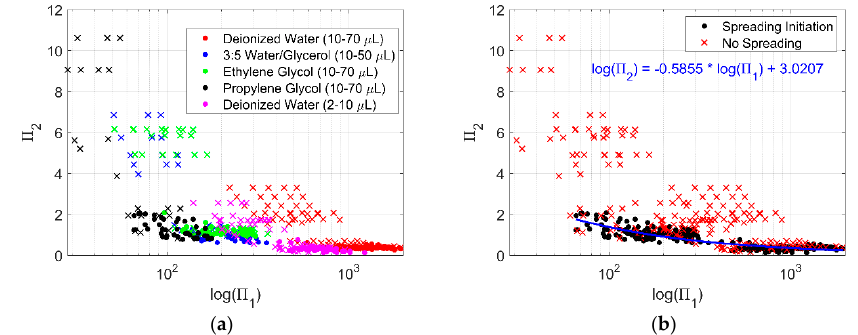
Figure 7. log ( Π 1 ) plotted against Π 2 . ( a ) Data plotted as dots represent variable conditions at the initiation of droplet spreading for each corresponding liquid, while the data plotted as an “x” represent variable conditions when droplets for each corresponding liquid did not spread. ( b ) The same data as ( a ), but without di ff erentiating between liquid. A black dot represents the point where spreading initiated, a red “x” are conditions without spreading. A linear regression of the log-log data for the condition where droplets begin to spread is shown in blue with the equation noted in ( b